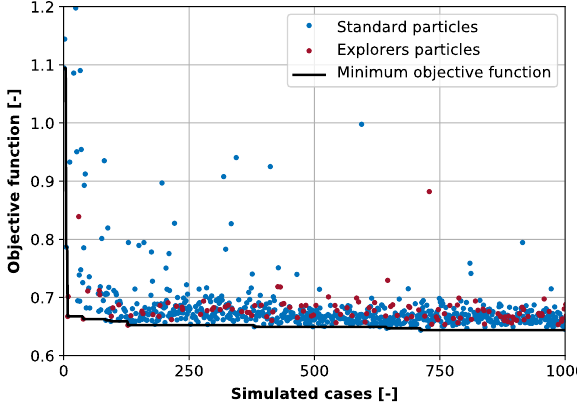
Figure 7. Objective function convergence